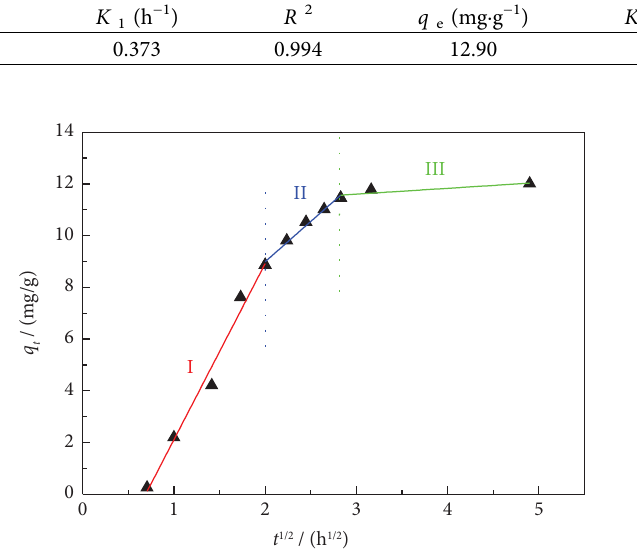
Figure 11: Linear ftting using the intraparticular difusion model.